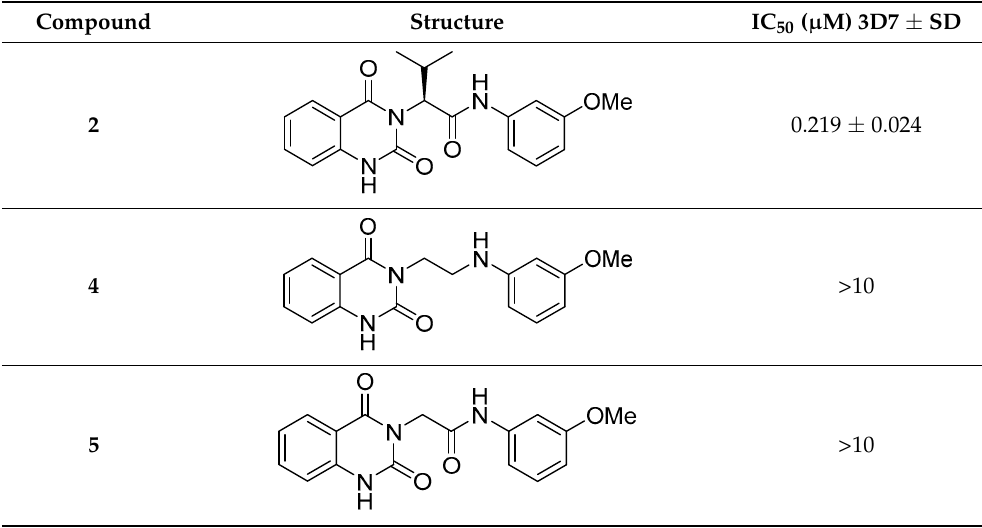
Table 2. In vitro antimalarial activities against P. falciparum 3D7 of quinazolinedione derivatives with various amino-acid linkers.